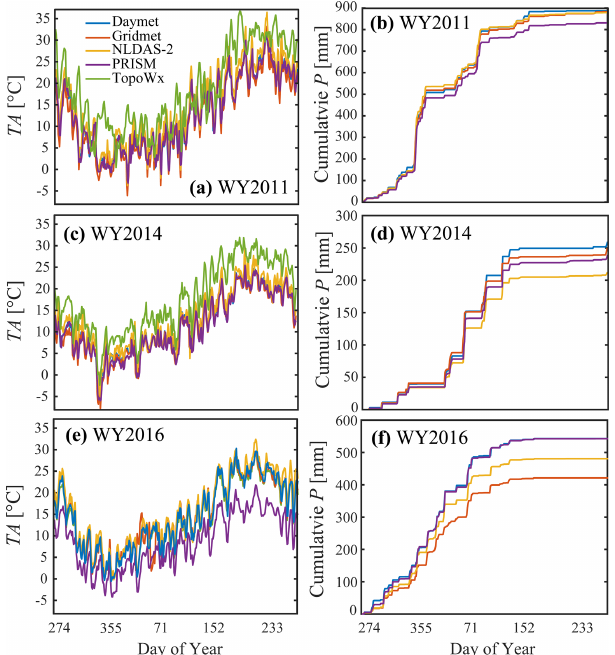
Figure 3. (a, c, e) Daily domain-averaged values of air temperature for five temperature datasets and (b, d, f) the cumulative sum of domain-averaged precipitation for each of the four gridded datasets in (a, b) WY2011, (c, d) WY2014, and (e, f)